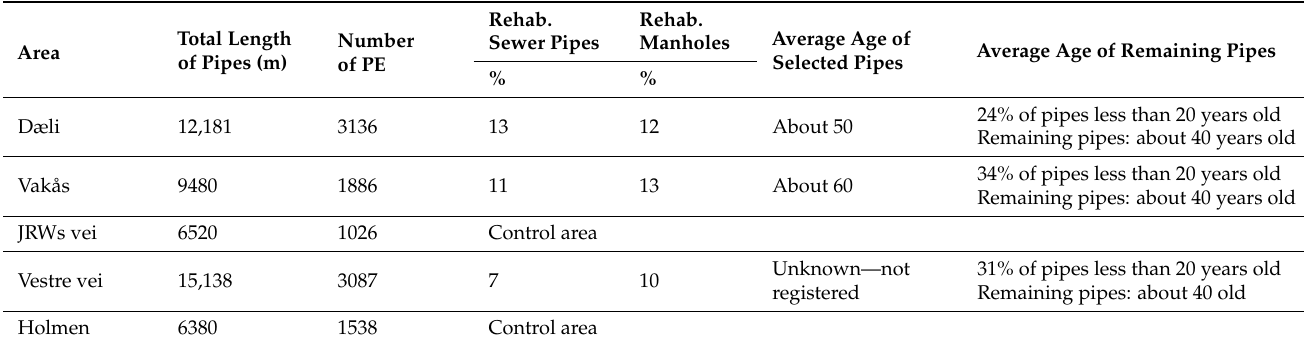
Table 2. Characteristics of the wastewater systems in Dæli, Vakås, and Vestre vei.